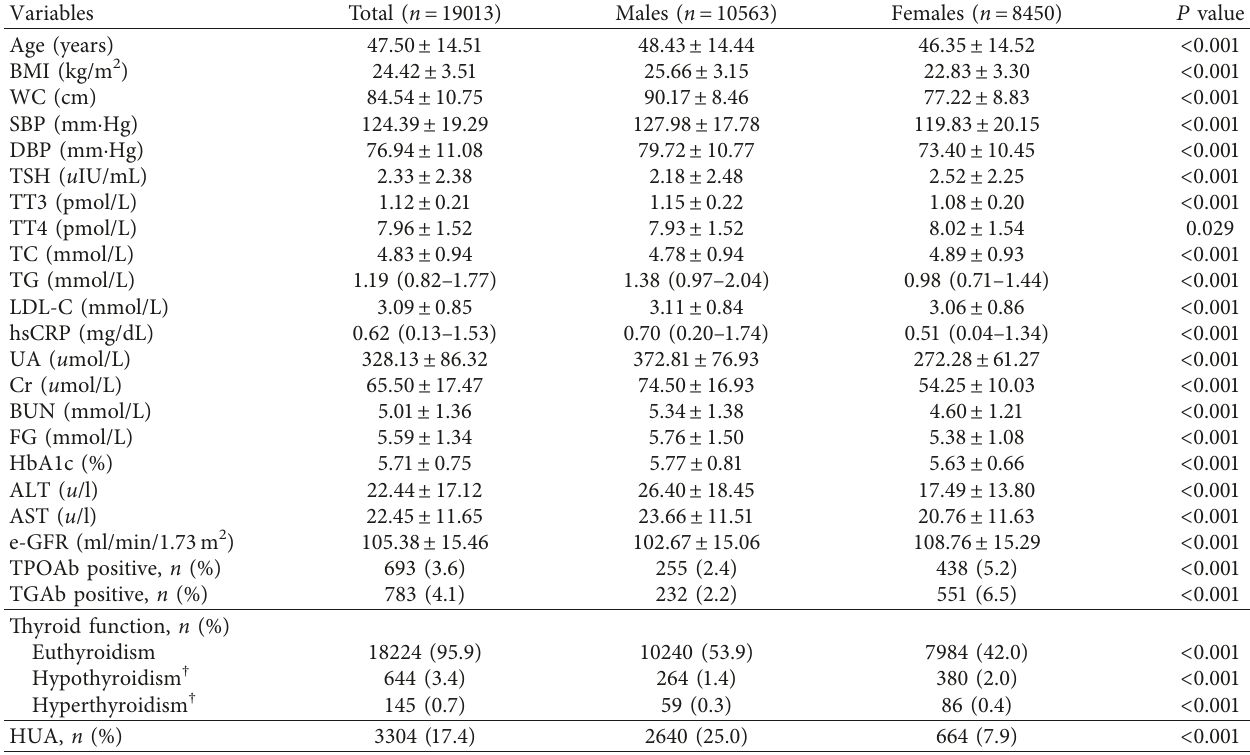
Table 1: Population characteristics based on different genders.